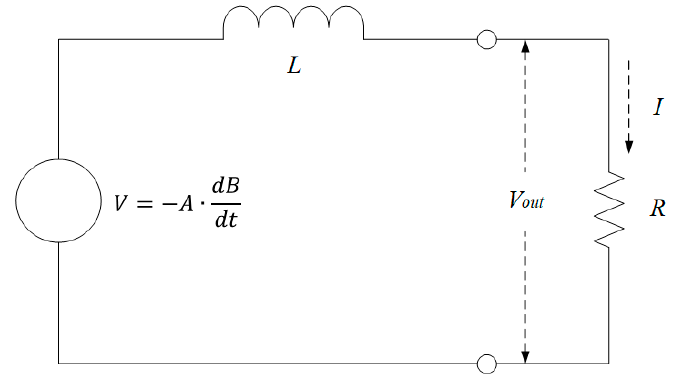
Figure 4. Equivalent circuit of loop antenna.